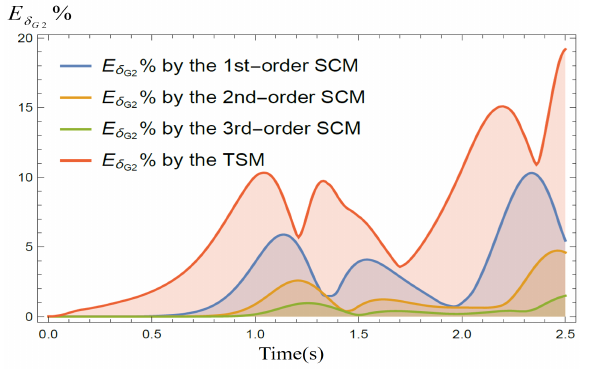
Figure 5. Mean absolute percentage error of the SCM and the TSM in fault